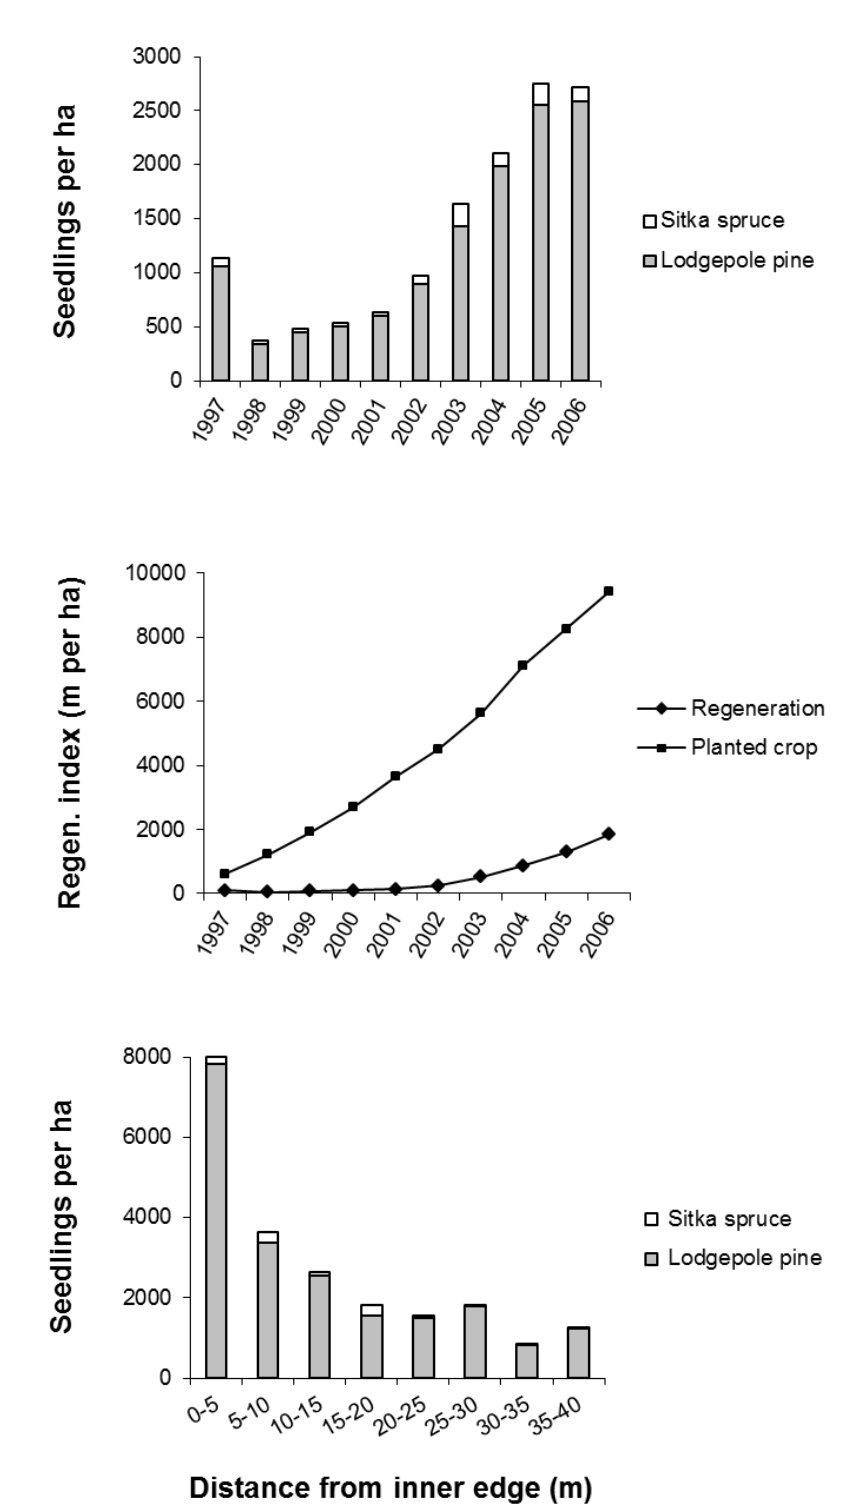
Figure 9. Tree regeneration in the felled treatments: (a) mean density over the four felled treatments (OF, OR, DF and DR) ten years after restoration; (b) regeneration index (summed height per ha) for each treatment over ten years compared to that of a planted conifer crop on a similar site nearby; (c) distribution of regeneration across the treatment plots, from the inner edge adjoining forest (at 0 m) to the outer edge adjoining unplanted bog (at 40